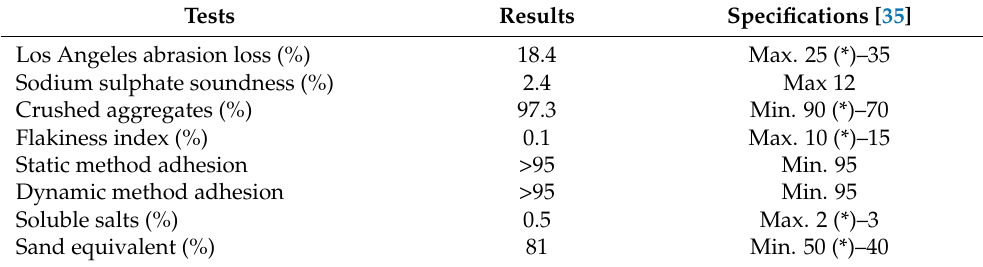
Table 3. Physical properties of aggregates.